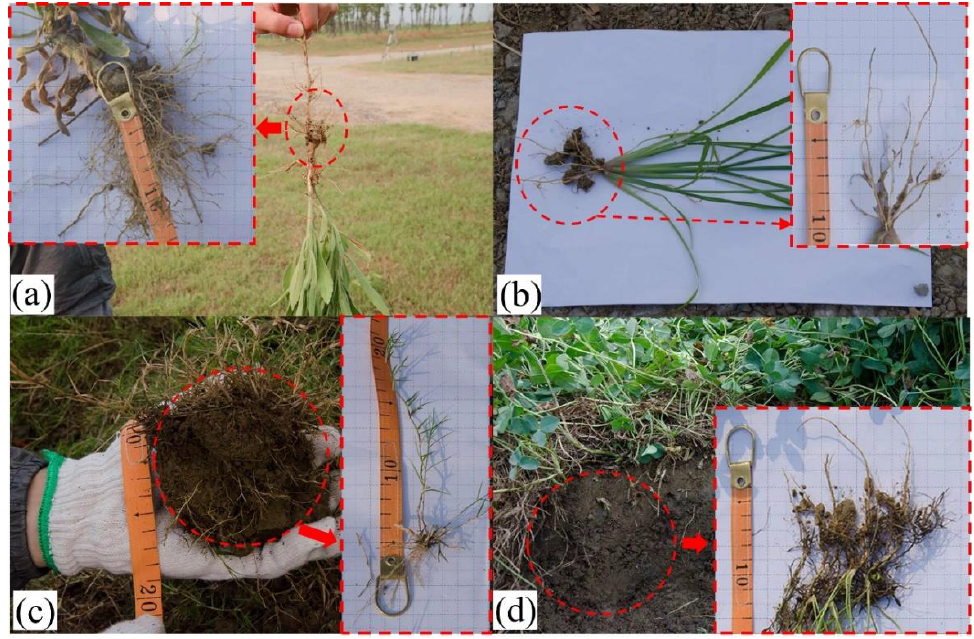
Figure 9. Photographs of the root systems in the field investigation: ( a ) Conyza Canadensis ; ( b ) Pas- palum ; ( c ) Bermuda grass ; and ( d ) Trefoil